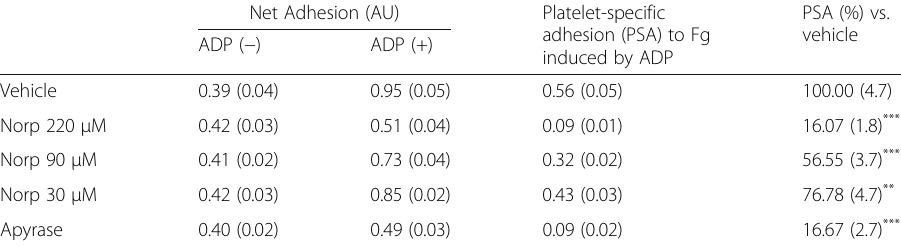
Table 1 Norpurpureine prevents ADP-induced platelet adhesion onto fixed fibrinogen Net Adhesion (AU) Platelet-specific adhesion (PSA) to Fg induced by ADP